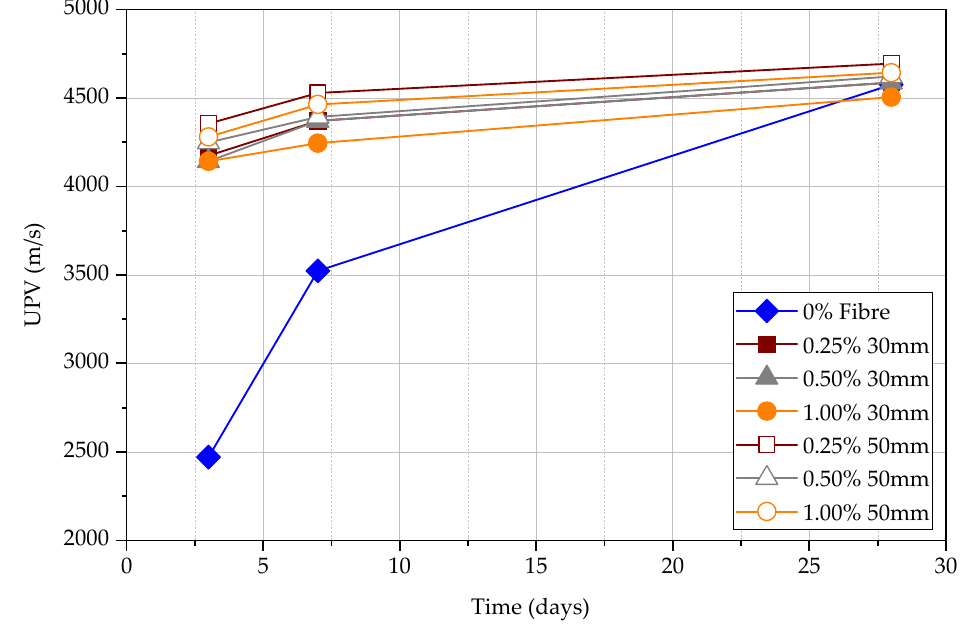
Figure 11. Direct UPV measurements at 3, 7, and 28 days.